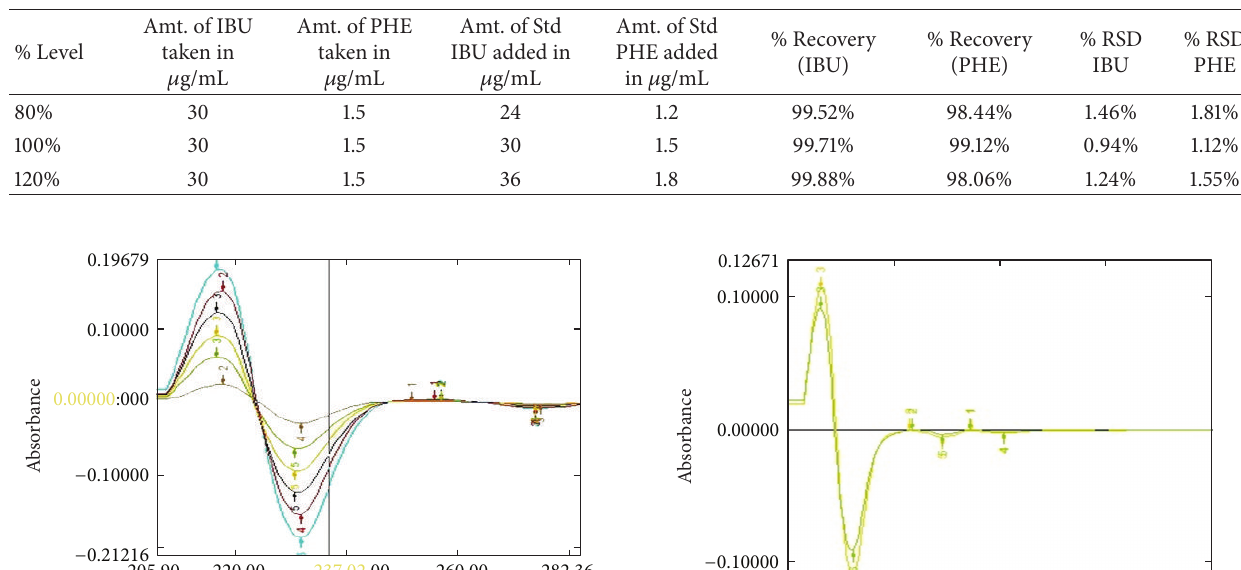
Table 2: Results of recovery studies (tablet).